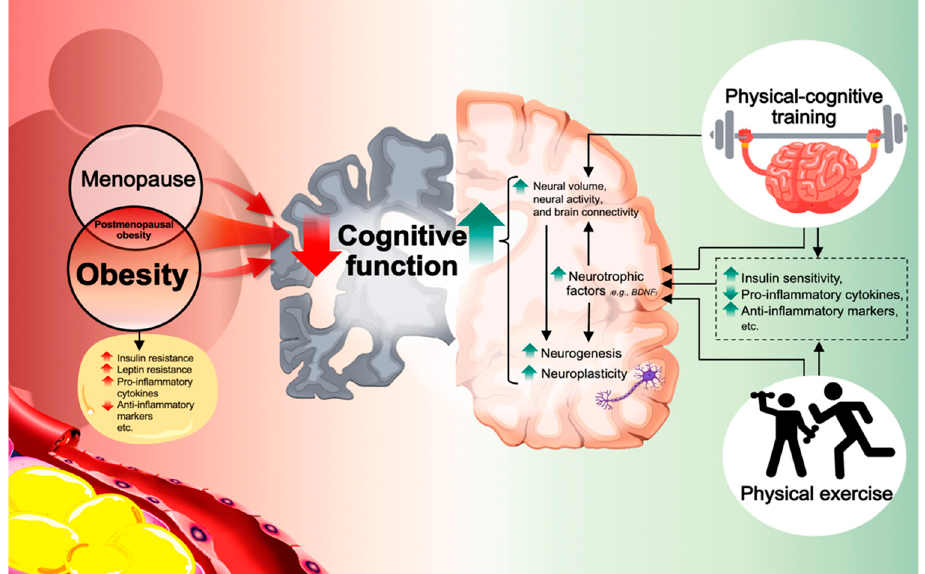
Figure 1. Scheme illustrating the possible mechanisms of physical exercise and physical–cognitive training on cognitive improvement . Obesity and menopause (estrogen deprivation) are both inde- pendently associated with cognitive impairment. Further, when overlapping, these conditions may magnify and aggravate cognitive decline. Either obese or menopausal condition is linked with met- abolic dysfunction and systematic inflammation, etc., which results in cognitive impairment. Both physical exercise and physical–cognitive training improved insulin sensitivity, decreased pro-in- flammatory cytokines, and enhanced anti-inflammatory markers, resulting in improved neu- rotrophic factors, neurogenesis, and neuroplasticity, and consequently lead to cognitive improve-